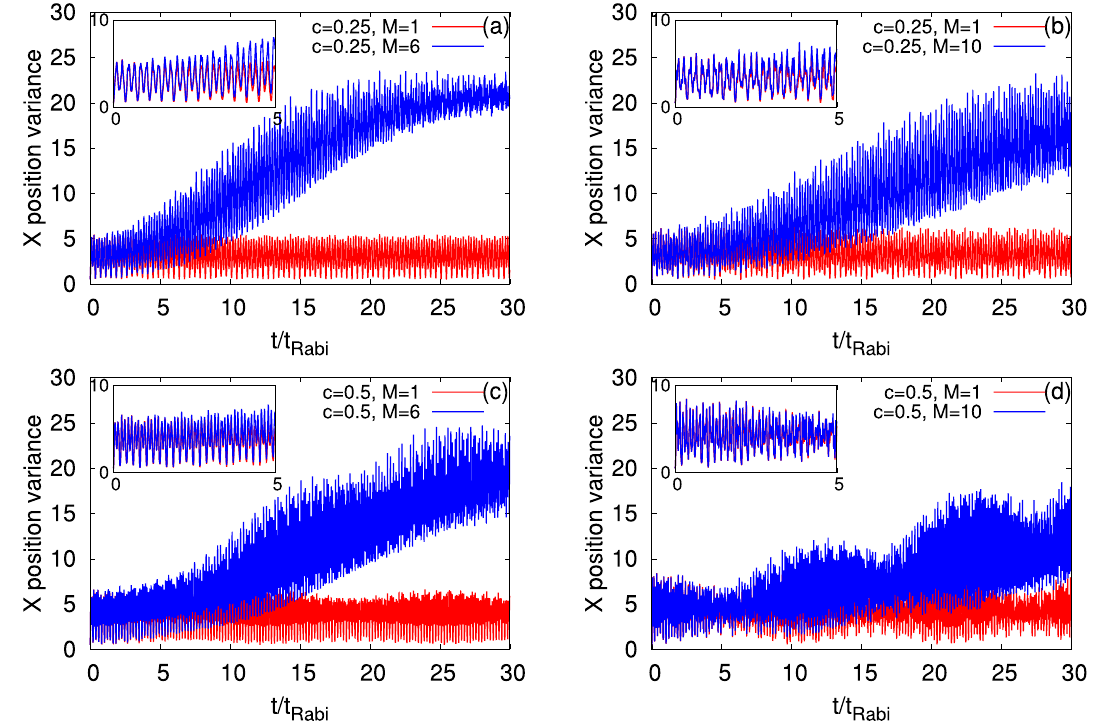
1 � 2 ( t ) , in a longitudinally- Figure 5. Time-dependent position variance per particle along the x -direction, N X ˆ 10 bosons with the asymmetric 2D double-well potential for (cid:31) G (left column) and (cid:31) Y (right column) of N = 1 0.01 π . The upper and lower rows show � 2 ( t ) at the resonant tunneling with interaction parameter � N X = ˆ 0.25 and 0.5, respectively. M 1 signifies the mean-field results. The many-body asymmetry parameter, c = = 6 time-dependent orbitals for (cid:31) G and M 10 time-dependent orbitals for dynamics are computed with M = = 1 0 to 5 t Rabi timescale of � 2 ( t ) is highlighted in the inset of each panel. We show here (cid:31) Y . From t N X = ˆ dimensionless quantities. Color codes are explained in each